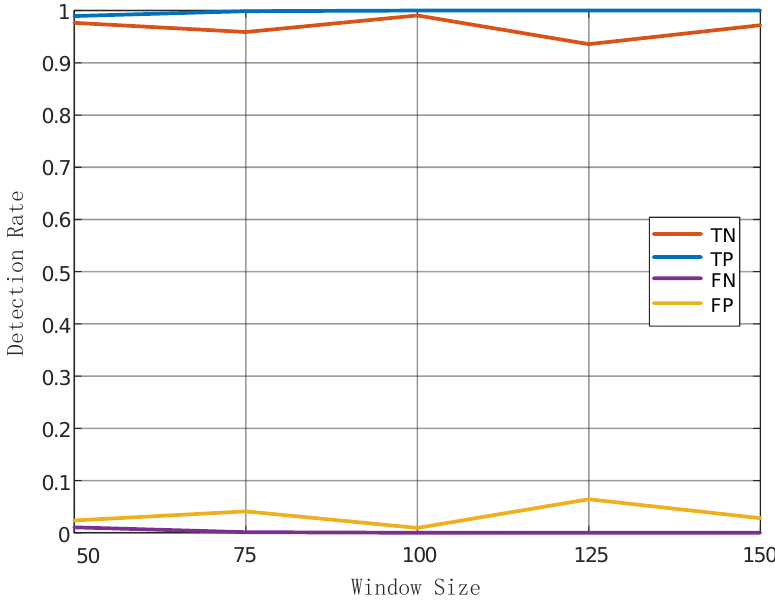
Figure 12. Relationship of detection rate and sliding window size.